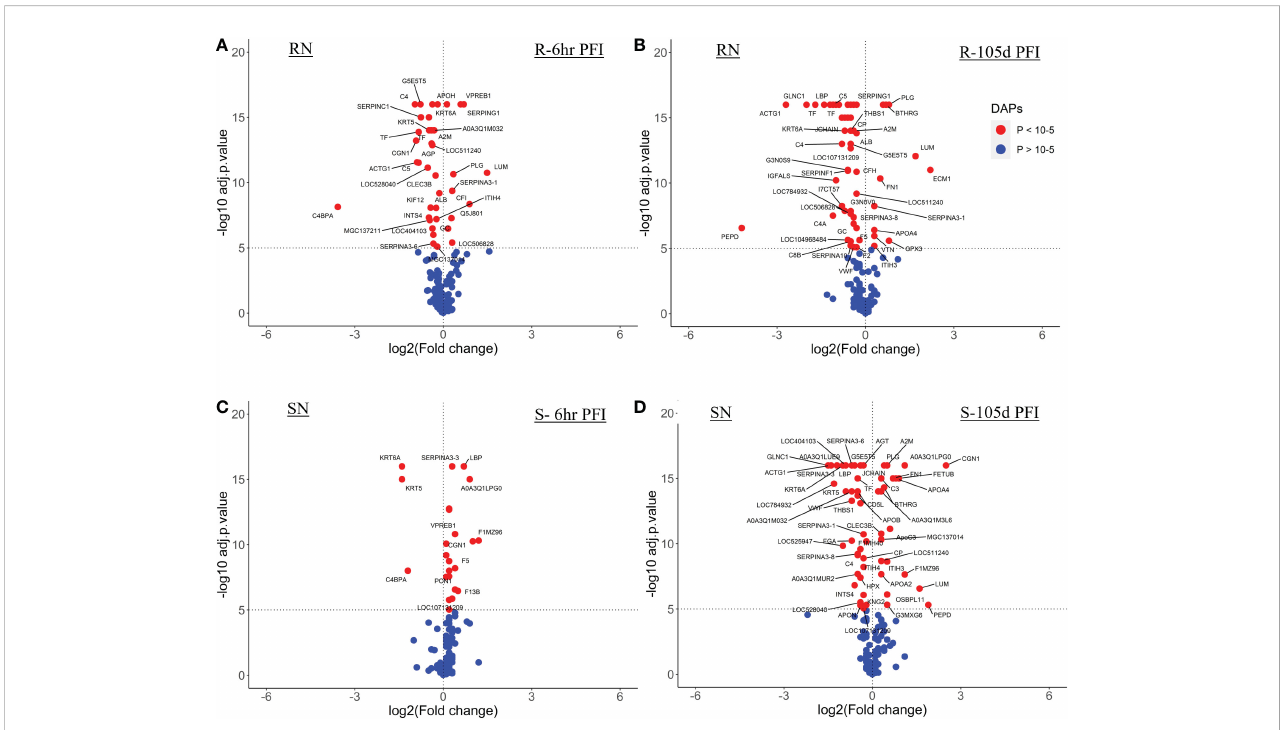
FIGURE 3 Volcano plots illustrating the differentially abundant proteins in serum samples from tick-resistant and susceptible naïve cattle in response to early (6 hr post- fi rst infestation) and prolonged exposure (105 days post- fi rst infestation) to ticks. DA proteins in: (A) resistant naïve compared to early exposure (RN vs R-6h PFI) samples; (B) resistant naïve compared to prolonged exposure (RN vs R-105d PFI) samples from resistant cattle; (C) susceptible naïve compared to early exposure (SN vs S-6h PFI) samples and (D) susceptible naïve compared to prolonged exposure (SN vs S-105d PFI) samples from susceptible cattle. Coloured dots represent proteins signi fi cantly different in abundance (P < 10 -5 ). Red, signi fi cantly different in abundance (P < 10 -5 ). Blue, not signi fi cantly different in abundance (P > 10 -5